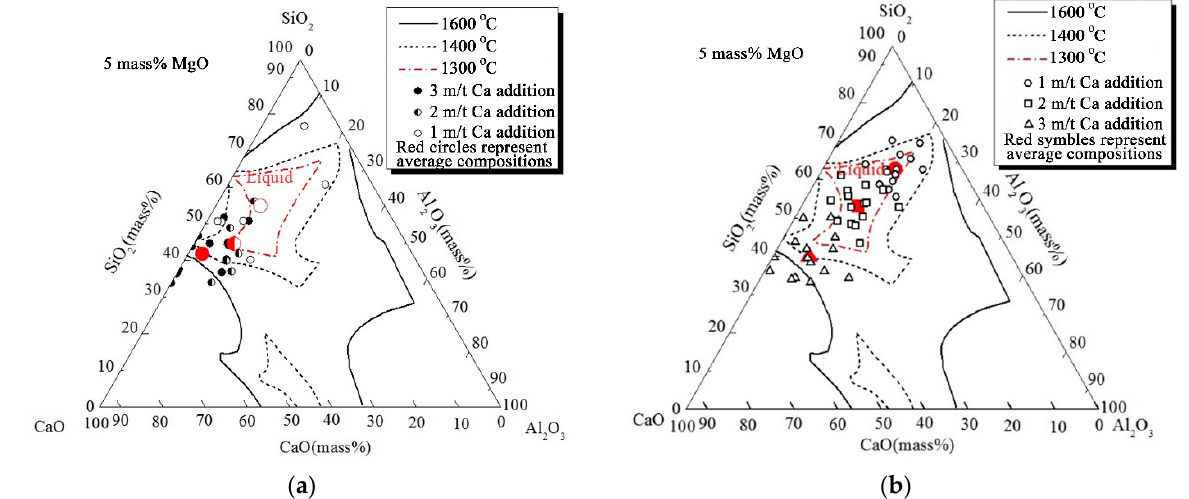
Figure 15. Compositions of oxide inclusions on CaO-SiO 2 -Al 2 O 3 -5 mass% MgO diagram: ( a ) the samples taken from liquid steel at the end of LF, ( b ) the samples taken from casting slab.